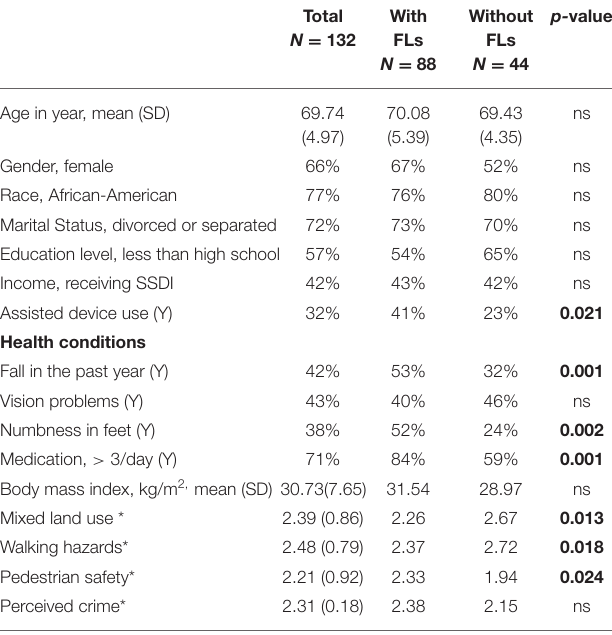
TABLE 1 | Characteristics of participants.